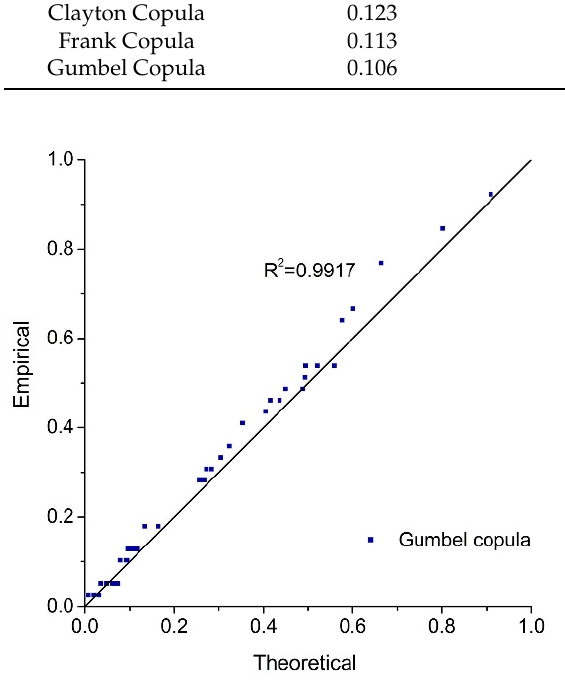
Table 4. Test of the goodness of fit of C ( u , v ) (non-parametric estimation method). Copula Function